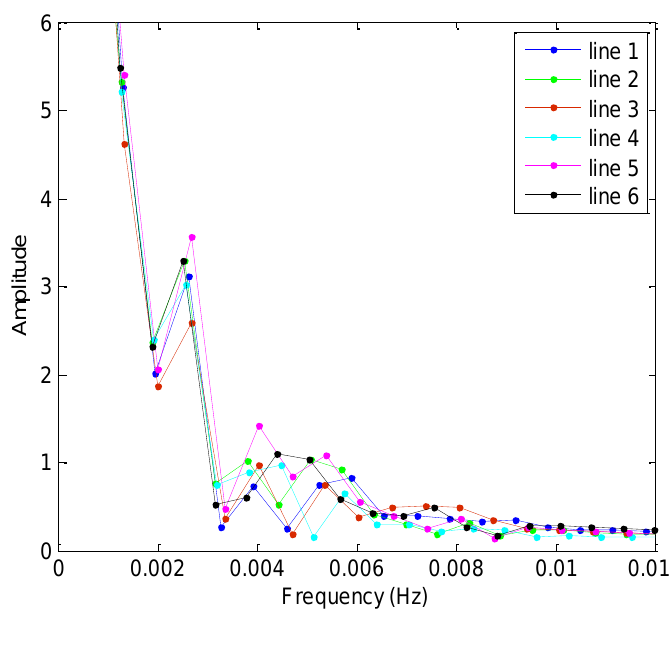
Figure 8. Amplitude spectrum curves of F401.